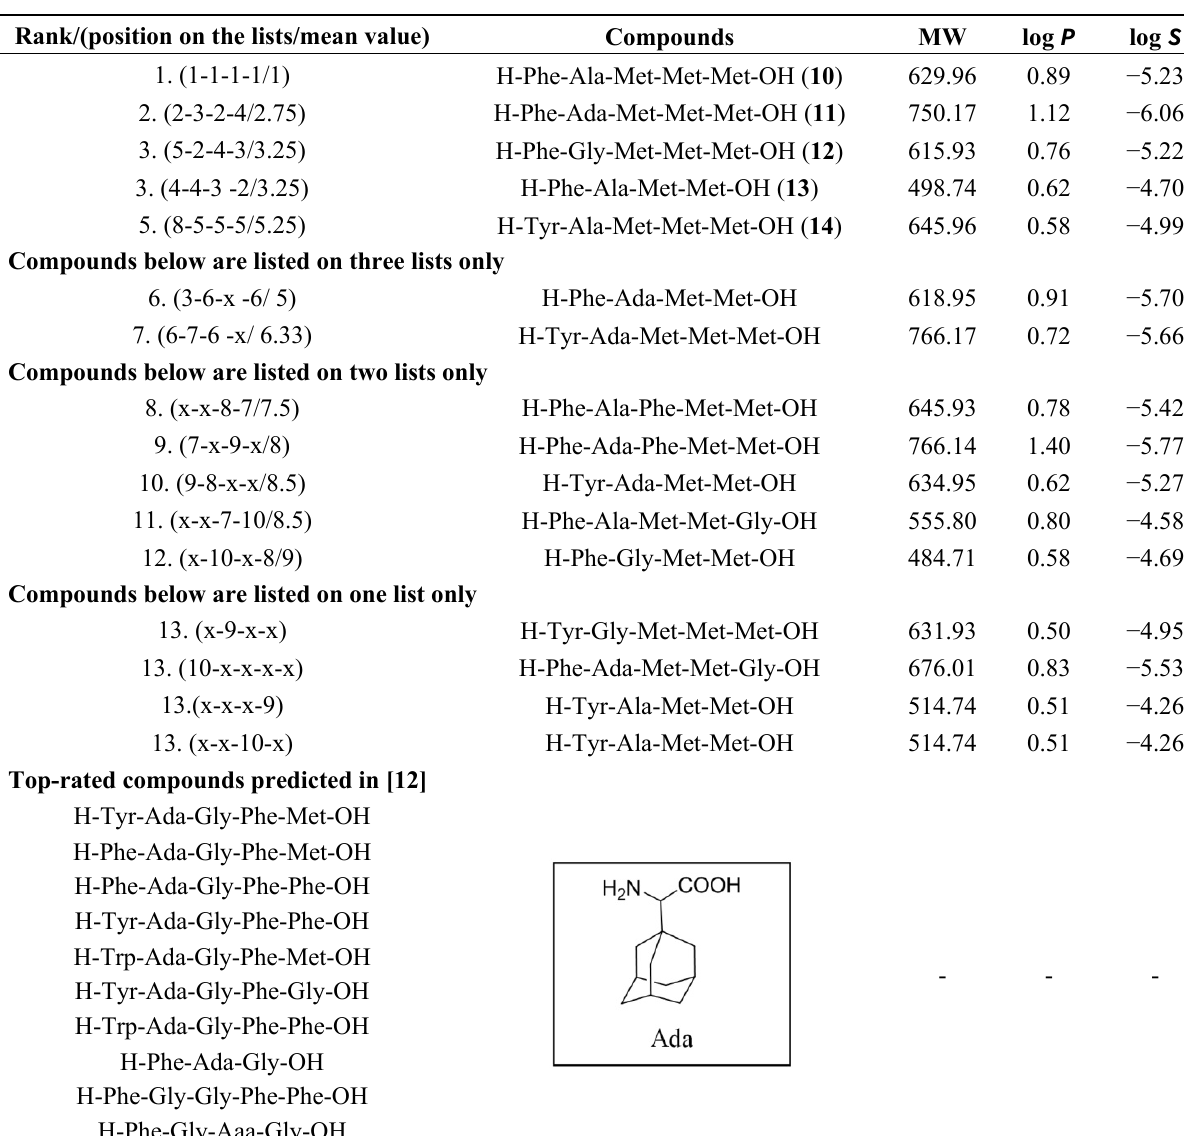
Table 1. Ranking list of the activity of virtual compounds as predicted by four regression models (linear SVM, sparse regression, MLP ANN, RBF SVM). Numbers in parentheses represent position of given compound on individual lists obtained by four regression